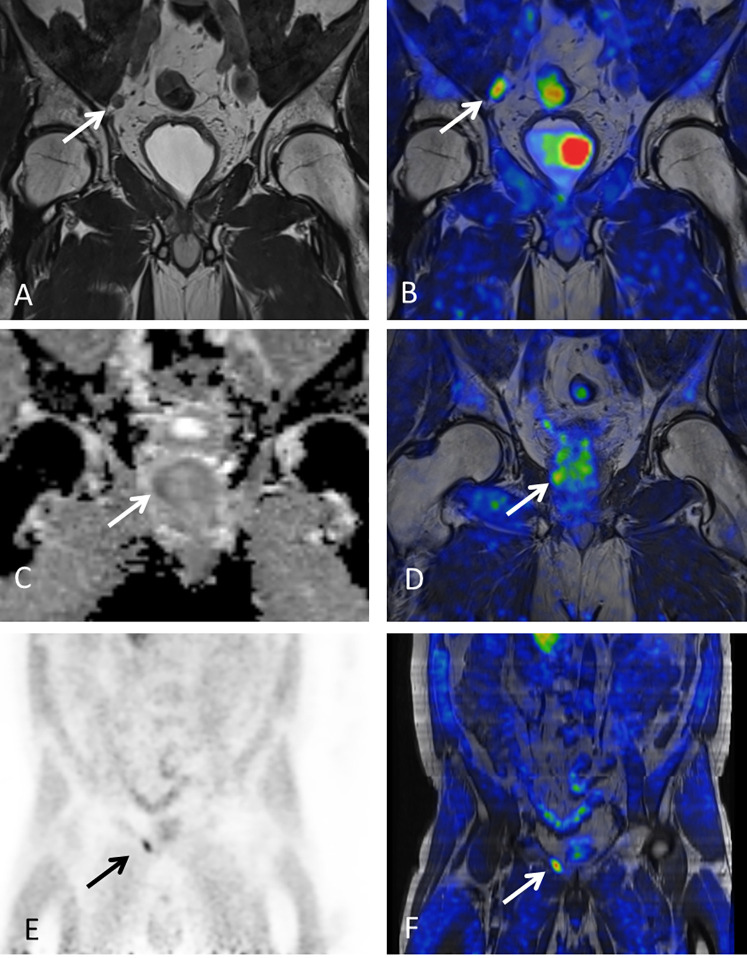
Examples of lesion visibility. Arrows point out lesions detected by 18F-fluciclovine PET/MRI. (A, B) 57-year-old patient with PSA of 0.6 ng/mL and one pelvic lymph node suspicious for metastasis based on mpMRI (A) and PET (maximum standardized uptake value [SUV max]=3.95) (B). (C, D) Prostatic lesion with restricted diffusion [Apparent diffusion coefficient (ADC)=982 x10−6mm2/s] (C) and increased tracer uptake (SUVmax=4.19) (D) in 62-year-old man with history of primary EBRT and PSA of 5.5 ng/mL at time of imaging. (E, F) Pelvic bone lesion (SUVmax=4.04) in 60-year-old male with PSA of 1.7 ng/ml. This lesion was initially missed by mpMRI but could be detected retrospectively.